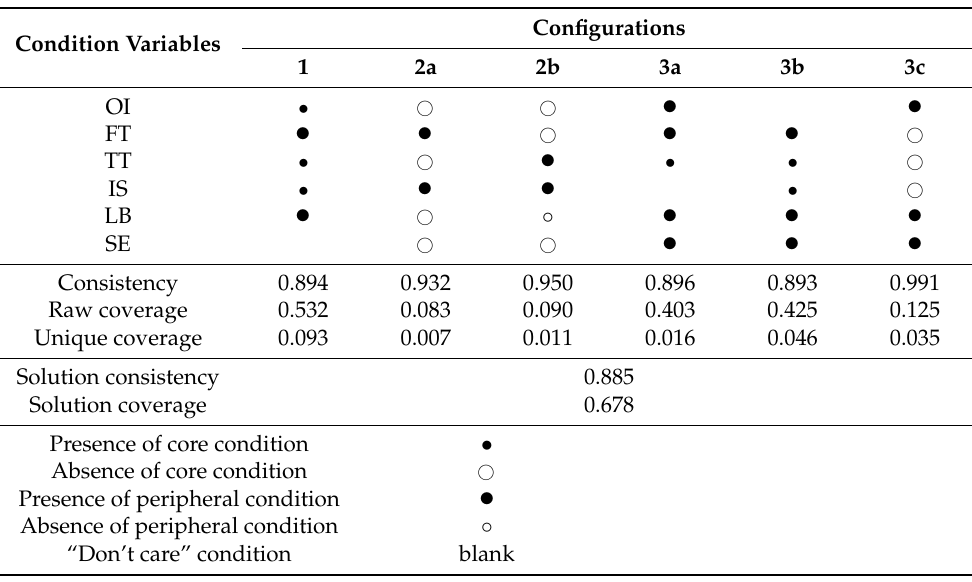
Table 5. Configurations for high venture